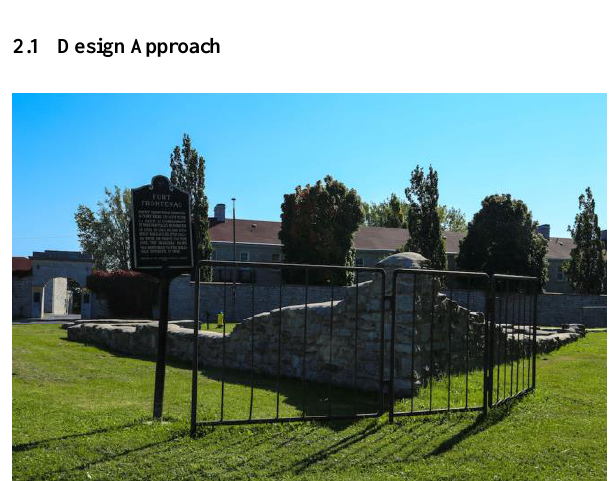
Figure 2. The remnants of Fort